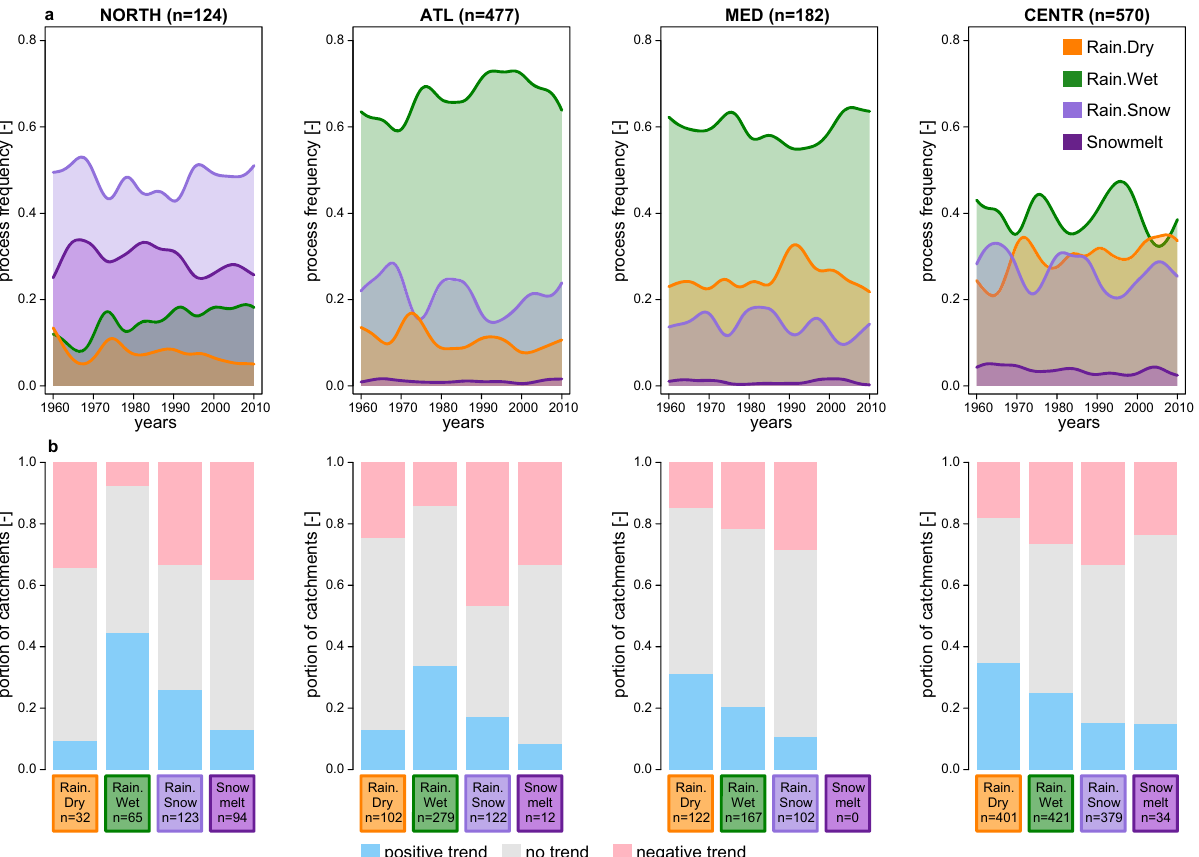
Fig. 2 Changes in fl ood generation processes in four European regions. a Changing annual frequency (smoothed using a kernel with a bandwidth of 7 years) of fl ood generation processes in the four European regions considered in this study: Northern (NORTH), Atlantic (ATL), Mediterranean (MED) and Central-Alpine (CENTR) (see Supplementary Fig. 3 for the location of the gauges) from 1960 to 2010. n is the number of catchments considered in each region. b Portion of catchments in each of the four regions with signi fi cant positive and negative trends (Mann – Kendall test, α = 0.05) in the frequency of each fl ood generation process (see Fig. 1 for trends in individual catchments). n is the number of catchments in each region that were analysed for each fl ood generation process, this number varies because only catchments with at least fi ve fl ood events generated by a respective process were considered for trend analysis (see “ Methods ”